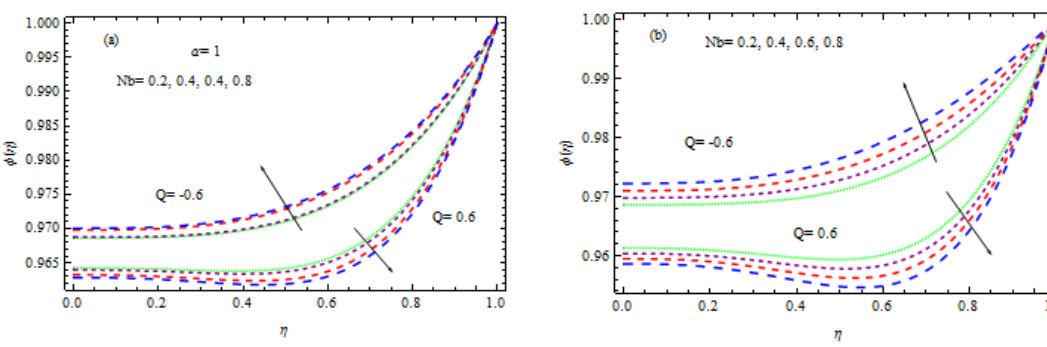
Figure 15. ( a , b ) Influence of Nb on temperature.